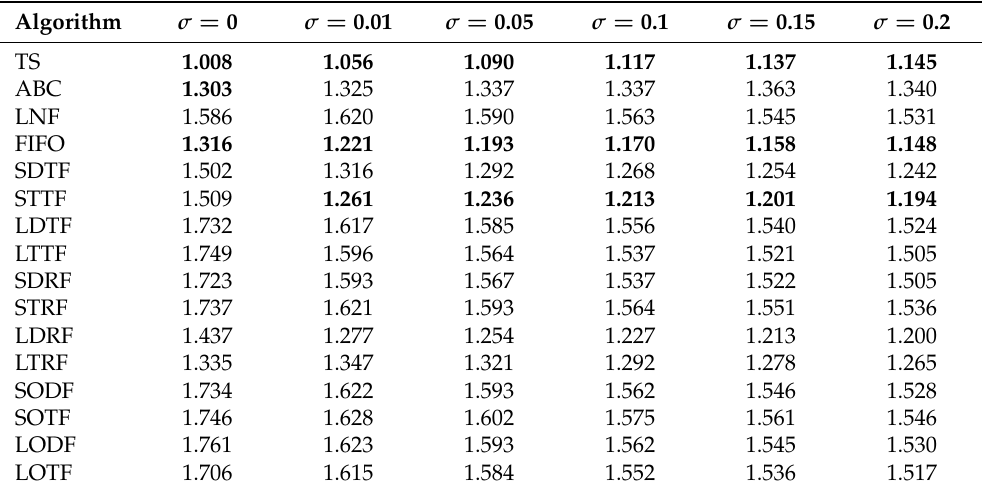
Table 5. Aggregated average PRD results for all benchmark instances (three best results for each scenario type in